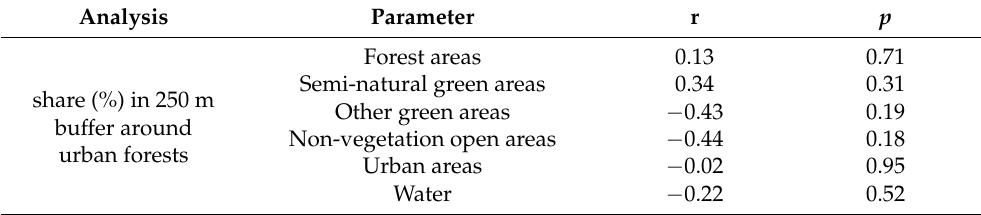
Table A4. Pearson correlation coefficients between selected environmental parameters describing landscape connectivity with occurrence of roe deer (mean frequency of occurrence per 100 trap-days) in urban forests of Warsaw as recorded by camera traps in the years